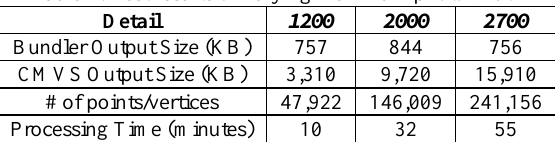
Table 4. Test results of varying maximum photo width